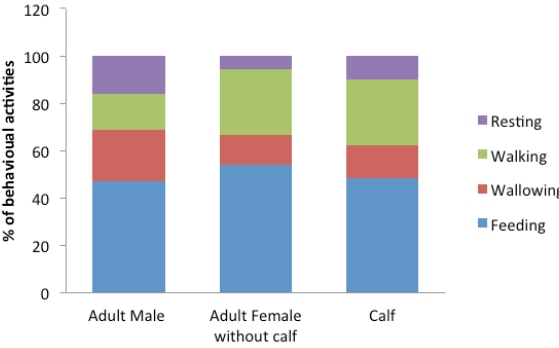
Figure 13. Behavior comparison of adult male, female and calves